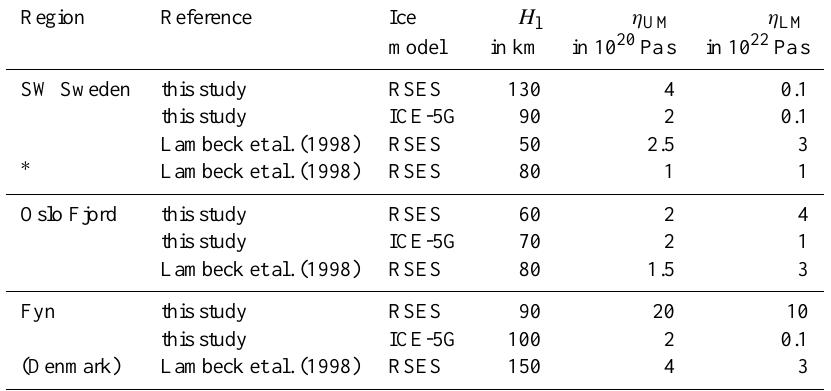
Table 2. Overview of three-layer 1-D earth models derived for regional RSL data subsets in the southern Baltic Sea. H l lithospheric thickness, η UM upper-mantle viscosity, η LM lower-mantle viscosity, χ misfit. ∗ This regional result from Lambeck et al. (1998) contains additional RSL data that were considered to be less satisfactory by Lambeck et al.